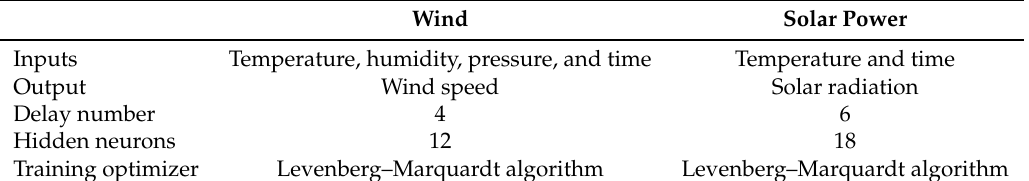
Table 1. Parameters for wind and solar generation forecasting.